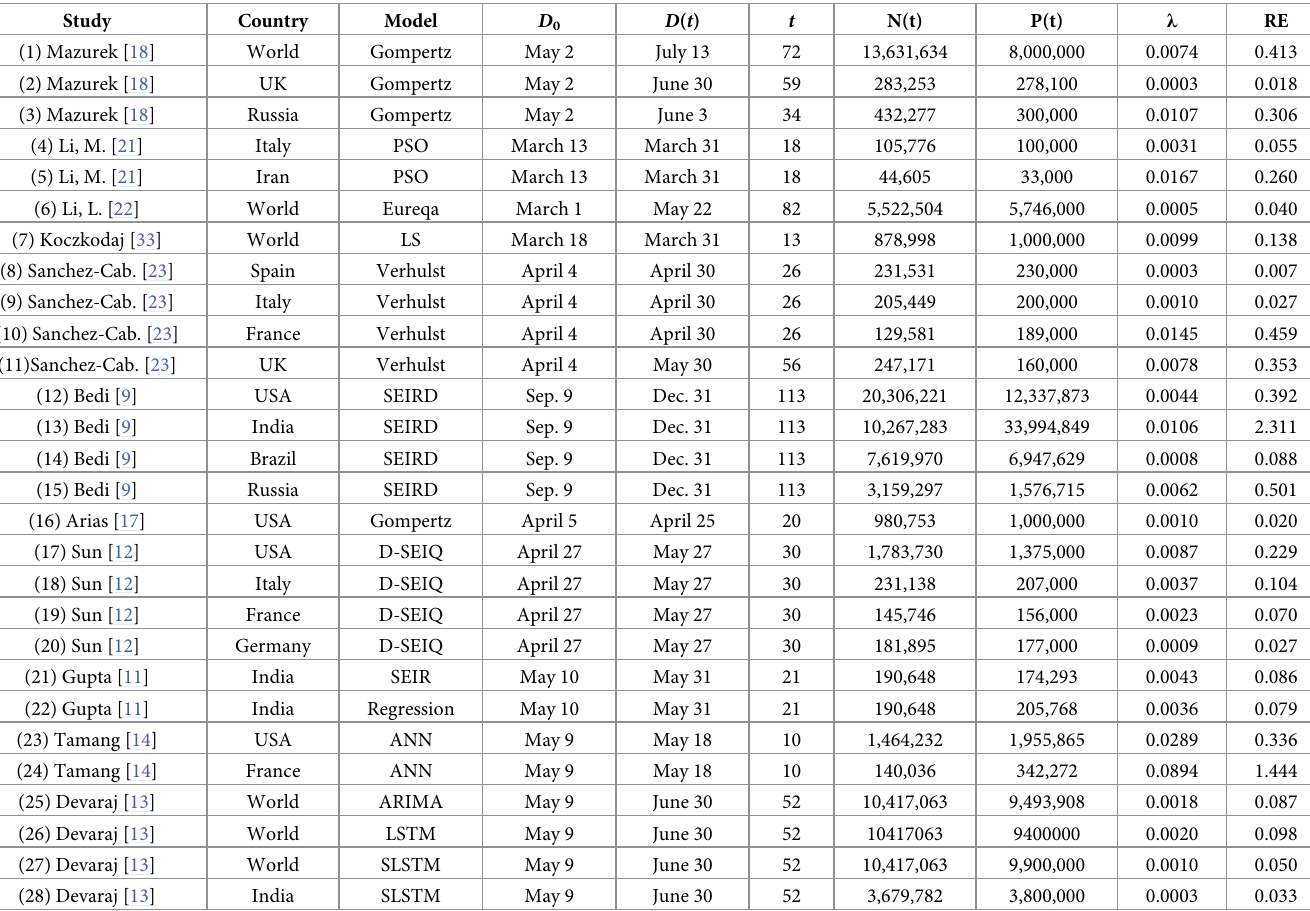
Table 3. The evaluation of prediction precision for selected models.